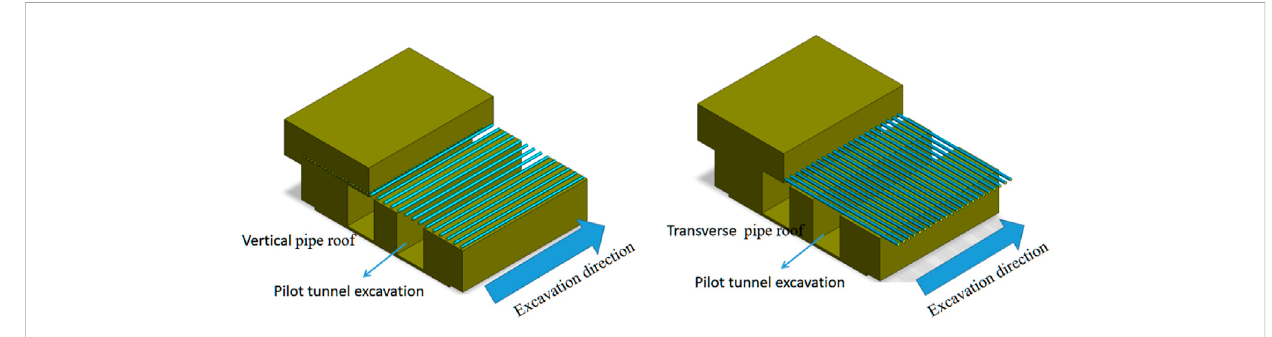
FIGURE 1 Pipe curtain arrangement form.